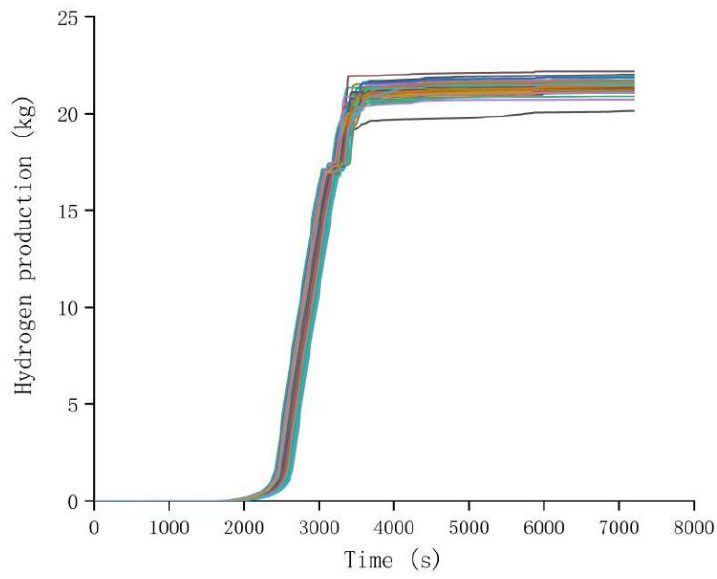
Figure 8. Hydrogen production of 59 calculation conditions in 38 mm LOCA.